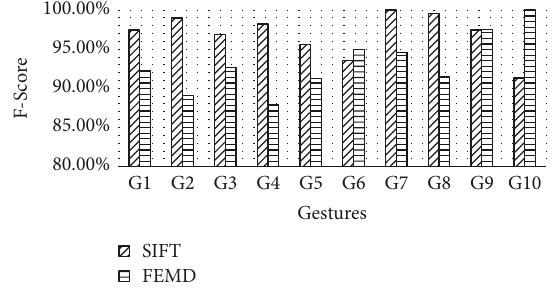
Figure 15: F-Score comparison between proposed approach and FEMD